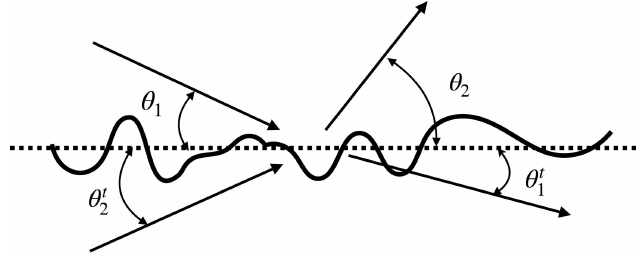
Figure 1 Schematic of a rough surface. The average surface is shown as a dashed line. The incident wave is incident at angle (cid:4) 1 ; its corresponding transmitted wave is at angle (cid:4) t . The scattered wave is at angle (cid:4) 2 and 1 corresponds to a time-reversed state in DWBA. It has a corresponding inside wave at angle (cid:4) t . The Z -axis is normal to the average 2